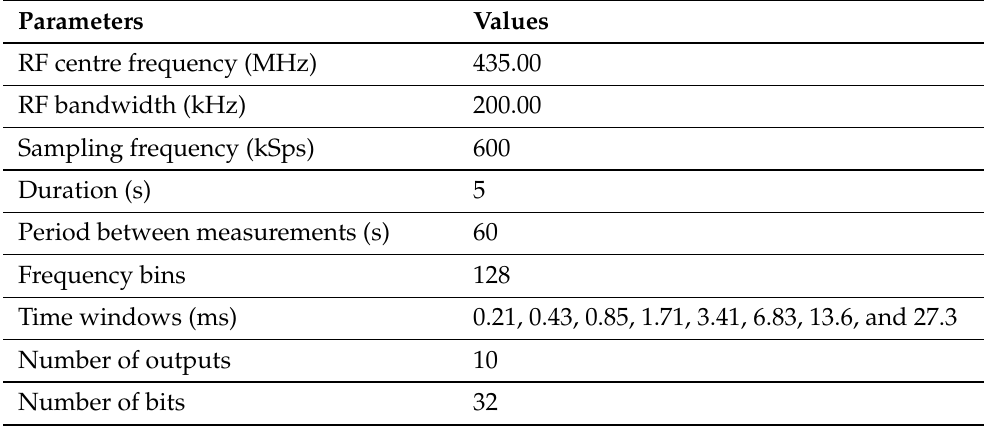
Table 1. Configuration parameters for simulations, as well as flatsat and in-orbit